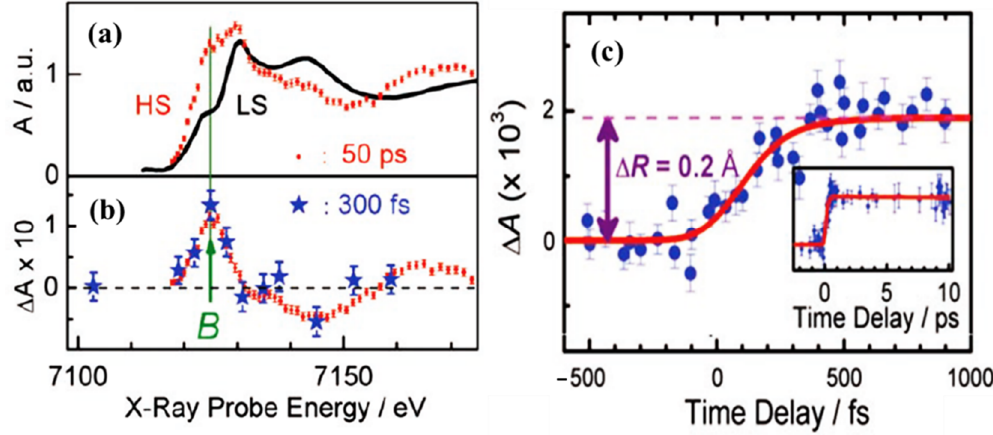
Figure 4. ( a ) The Fe K-edge XANES spectrum of [Fe II (bpy) 3 ] 2+ high spin state (red dots) and low spin state (black curve). The HS state was extracted from the transient spectrum ( b ) and the low spin spectrum. ( b ) The transient XANES spectrum recorded at 50 ps (red dots) and at 300 fs (blue stars) after the laser excitation. ( c ) Scans of the time evolution of the B-feature signal, with respect to the laser pump/X-ray probe time delay after excitation at 400 nm. The red curve is the simulated signal assuming four-step kinetic model. The inset shows the time scan done up to a 10 ps time delay. Reprinted with permission from Ref. [79]. Copyright 2009 American Association for the Advancement of Science.